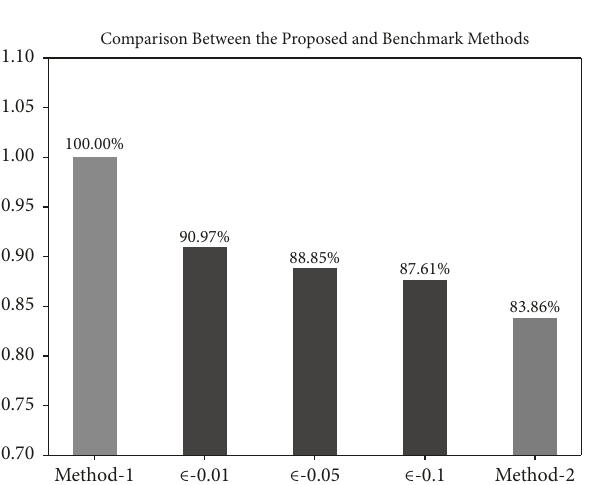
Figure 6: Comparison between the proposed and benchmark